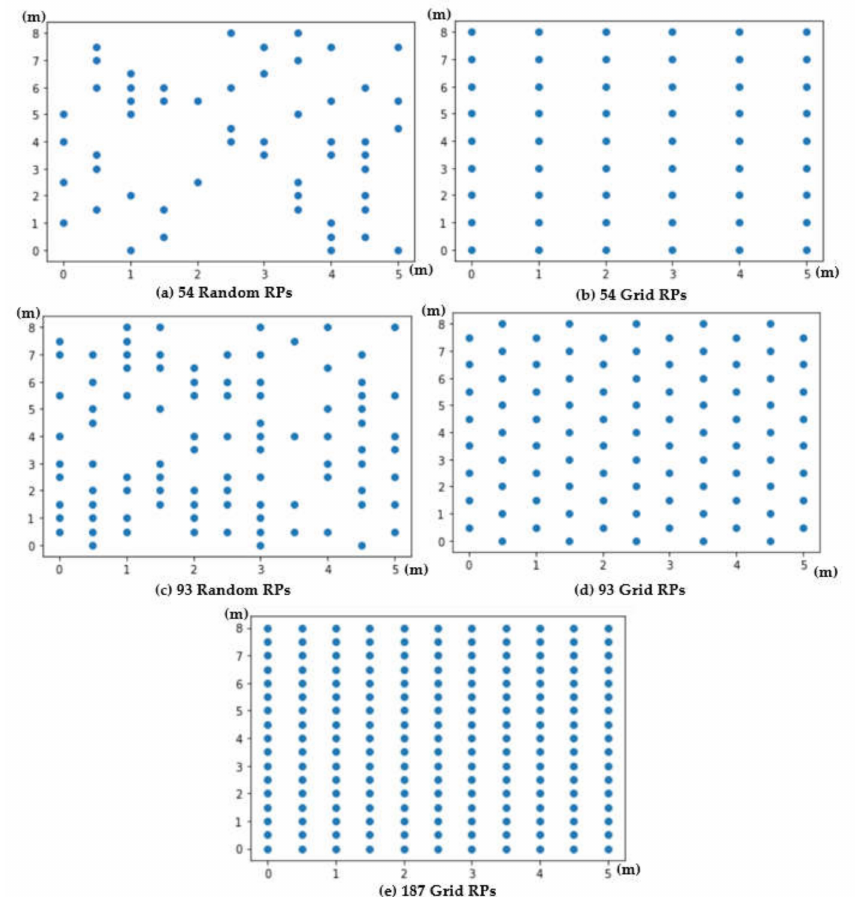
Figure 5. Different experimental scenarios of ( a ) 54 random RPs, ( b ) 54 grid RPs, ( c ) 93 random RPs, ( d ) 93 grid RPs, and ( e ) 187 grid